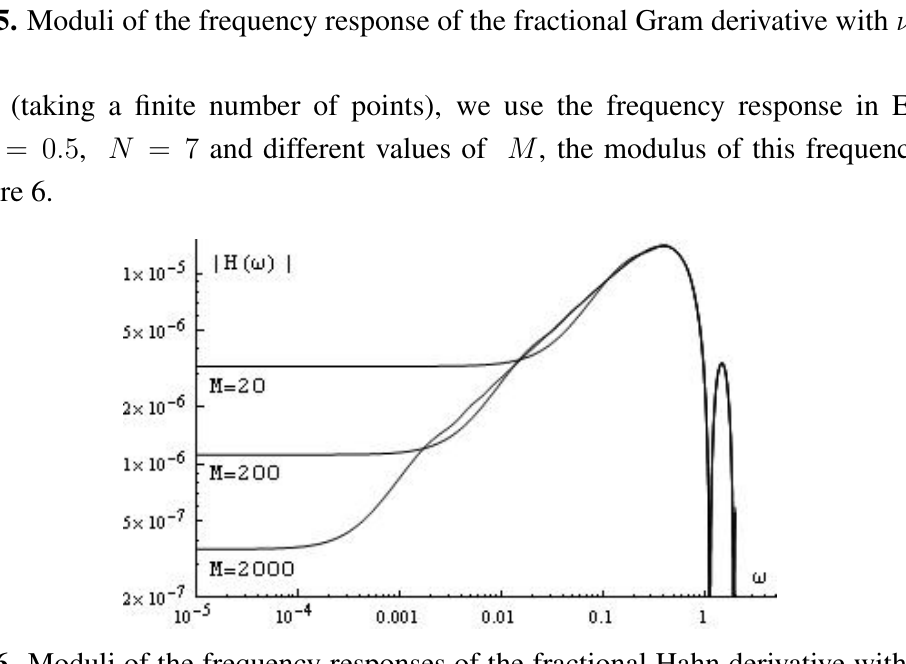
Figure 6. Moduli of the frequency responses of the fractional Hahn derivative with N = 7 and ν = 0 . 5